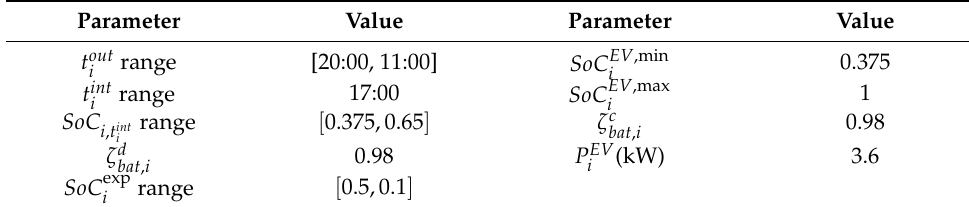
Table 2. Simulation parameters.